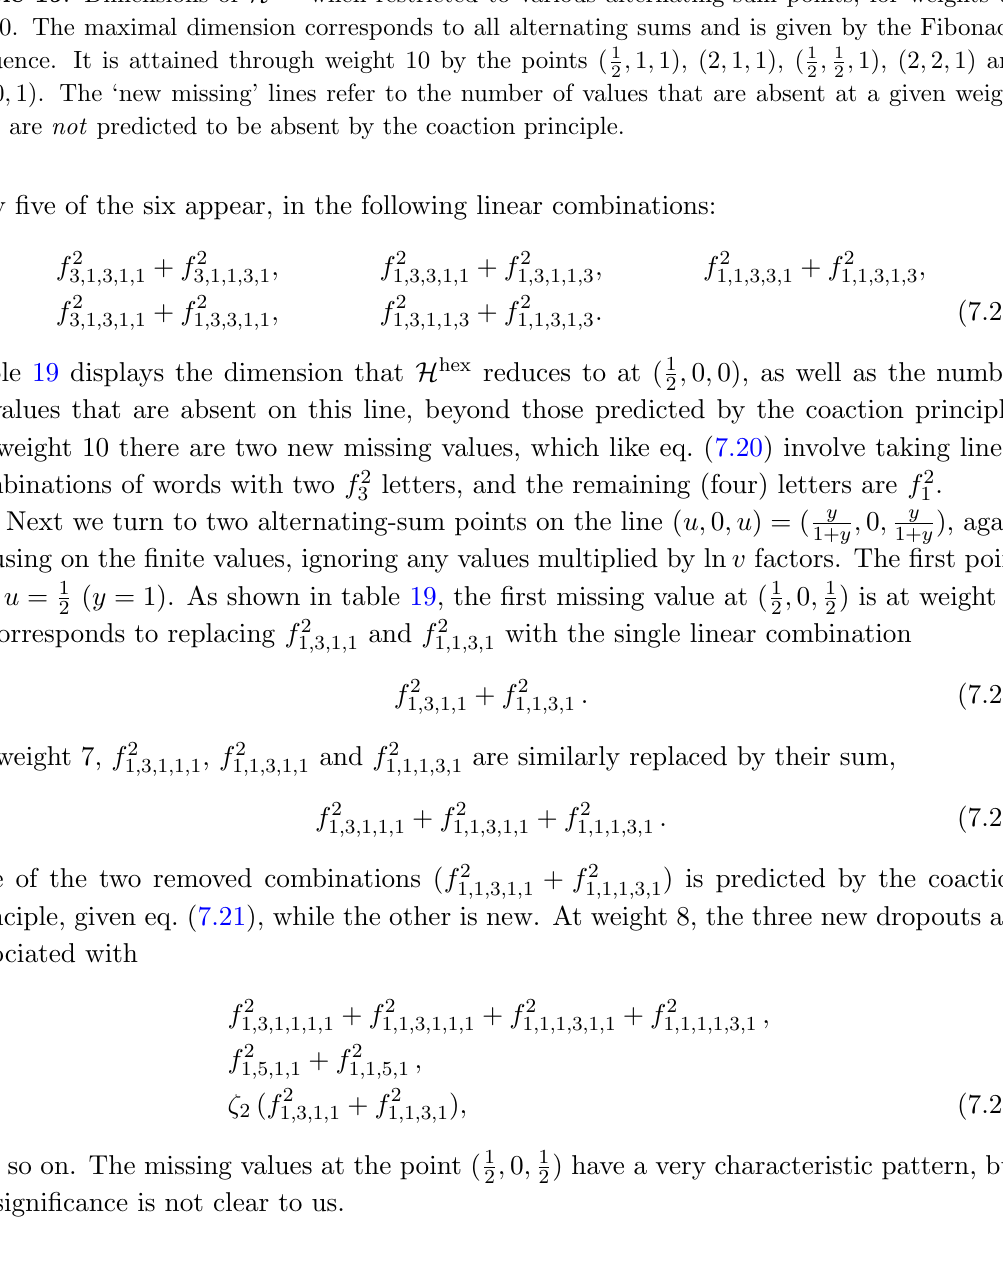
; 1 ; 1), (2 ; 1 ; 1), ( 1 ; 1 ; 1), (2 ; 2 ; 1) and 2 2 2